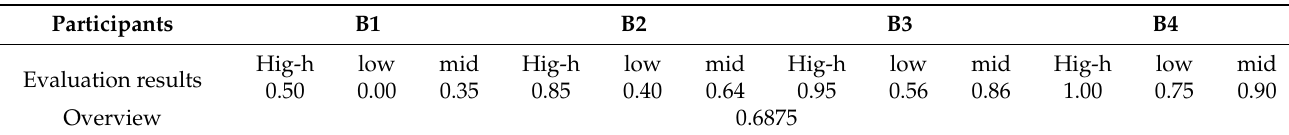
Table 8. Survey results of S r